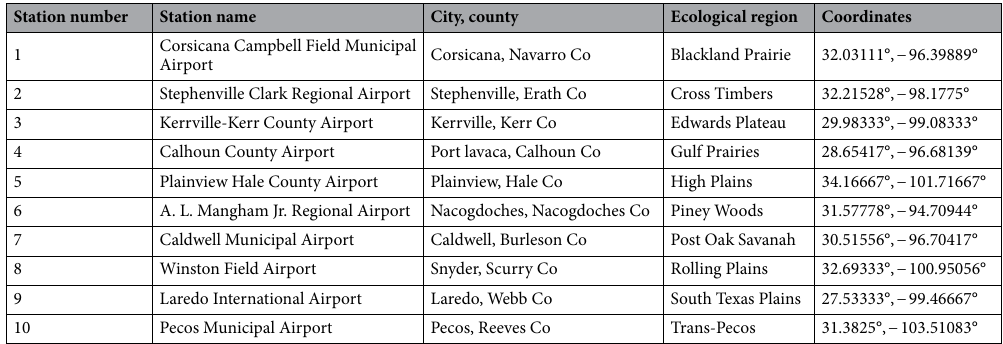
Table 1. Weather stations used to collect hourly